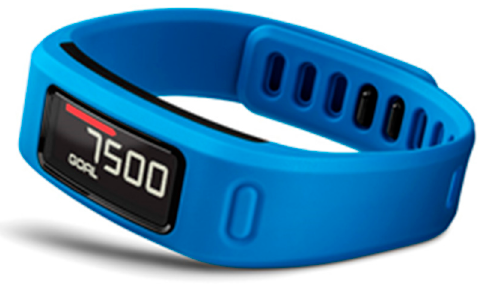
Figure 1. Garmin Vivofit 1—monitoring band [34].